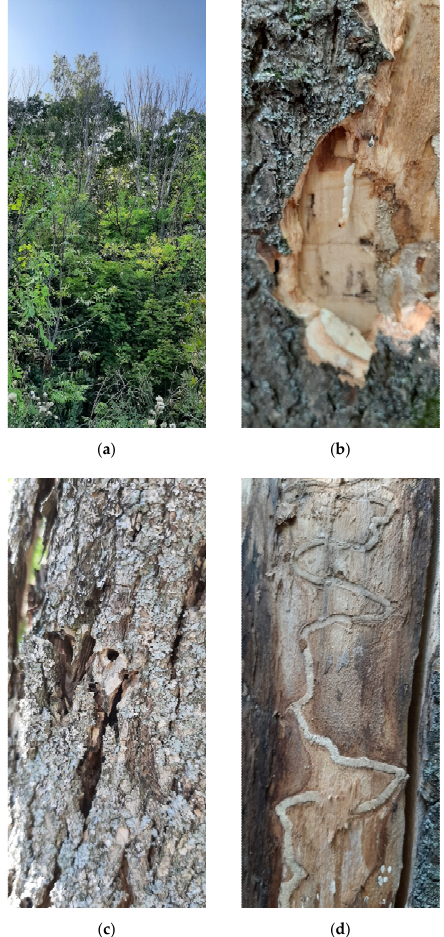
Figure 2. Signs and symptoms of EAB infestation of Fraxinus excelsior trees in Kokinskij Forest of Stupino Forestry near Ozherelie railway station (Kashira District, Moscow Province). ( a ) Trees with the upper part of main stems dead; ( b ) larva under the bark; ( c ) exit hole; ( d ) larval gallery.